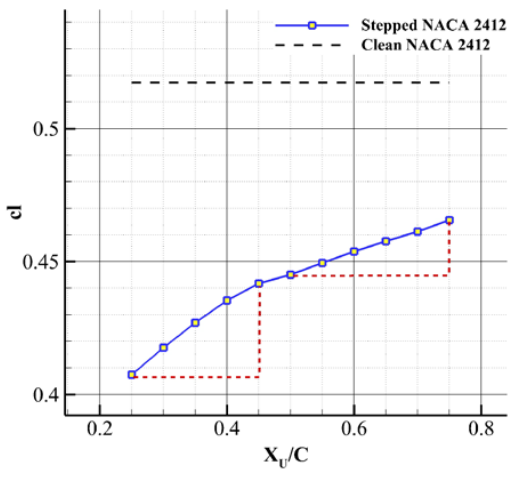
Figure 6. The variation of the lift coefficient at different step locations ( Re = 5.9 × 10 6 and α = 2.5 ◦ ). The dashed red lines emphasize the change in the slope of the obtained values.